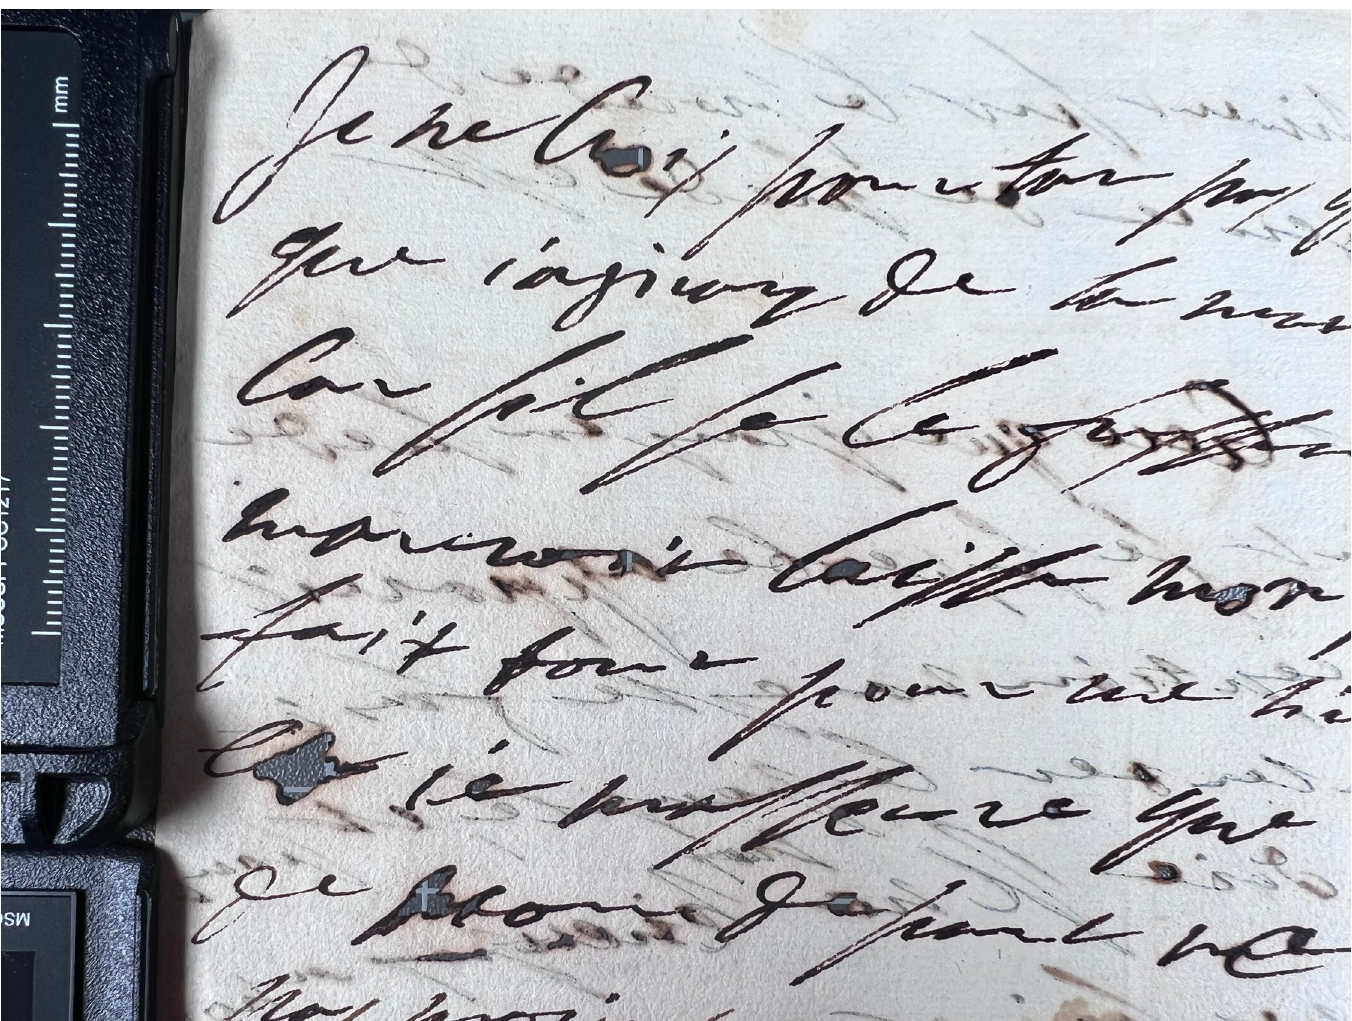
Fig 4. Burn through category 4. Example of document from the Azzolino collection displaying burn through 4, the document has text on both recto and verso.